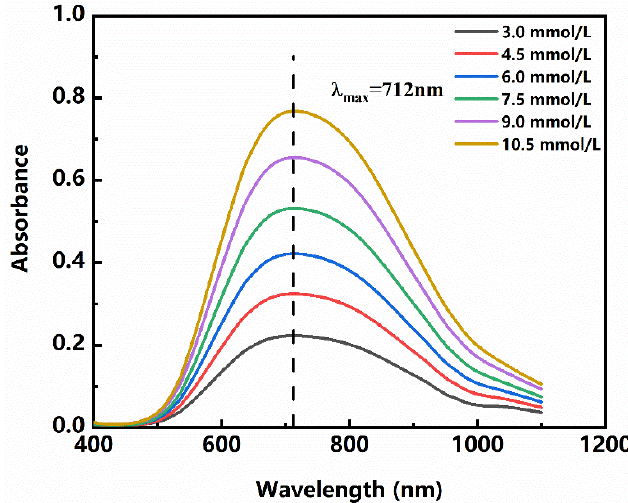
Figure 4. Absorption spectra of Cu 2+ with different concentrations in buffer solution.